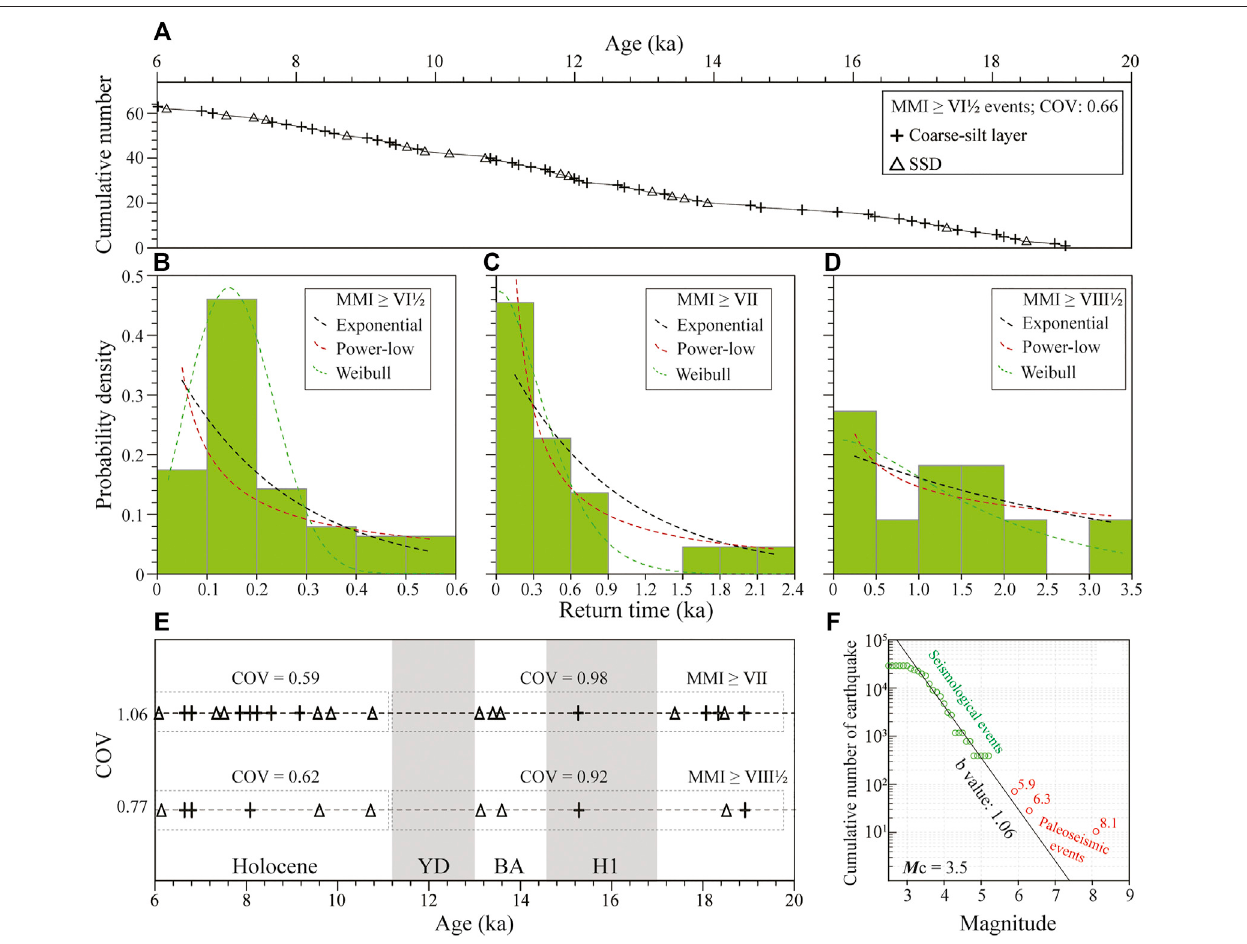
FIGURE 5 | Recurrence time statistics of seismites and magnitude constraint for strong seismic shaking events during 6.0 – 19.3 ka (A) Temporal distribution of moderate (MMI ≥ Ⅵ ½) seismic shaking events (B – D) Histograms for return times of MMI ≥ Ⅵ ½, ≥ Ⅶ , and ≥ Ⅷ ½ events. We plot difference distribution types (exponential, power-law and Weibull) for each dataset (E) Temporal distributions of strong and large earthquakes of the Lixian section (F) Magnitude-frequency distribution of modern (green colored) and paleoseismic (red colored) of the Lixian section during 6.0 – 19.3 ka.